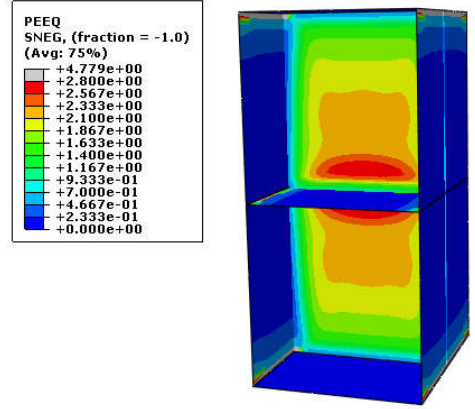
Figure 14. The plastic strain in this sample.